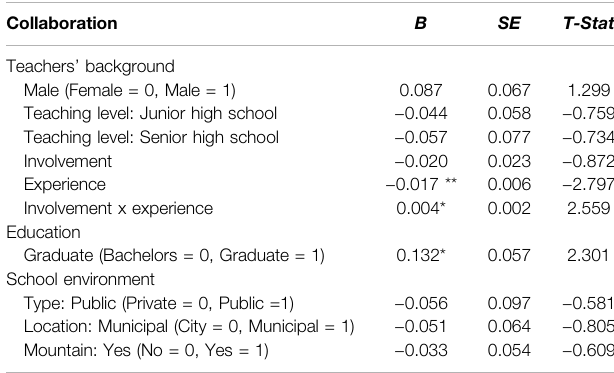
TABLE 7 | Regression results with the Collaboration Stage regressed on multiple predictors.